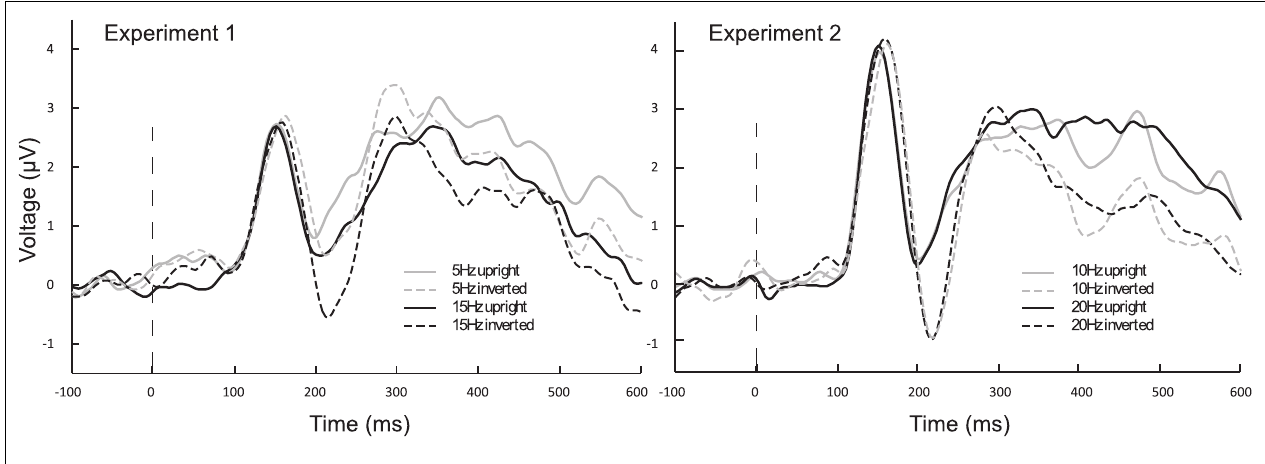
Experiment 1, where the 5Hz N170 is diminished in compared to all other inverted conditions. Black lines are faster frequencies, gray lines are slower frequencies, and solid lines are the upright conditions.